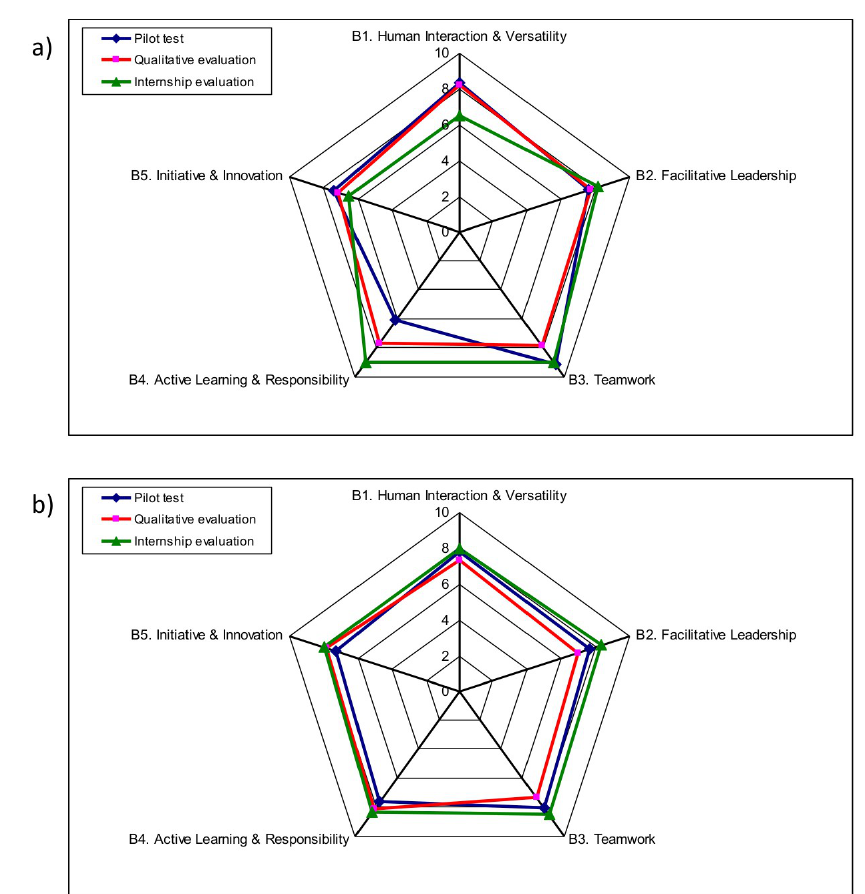
Figure 2. Competency level of two members, a) and b), of the team of fourth year (GEQ). Comparison between the results of the pilot test, the qualitatve evaluaton and the internship